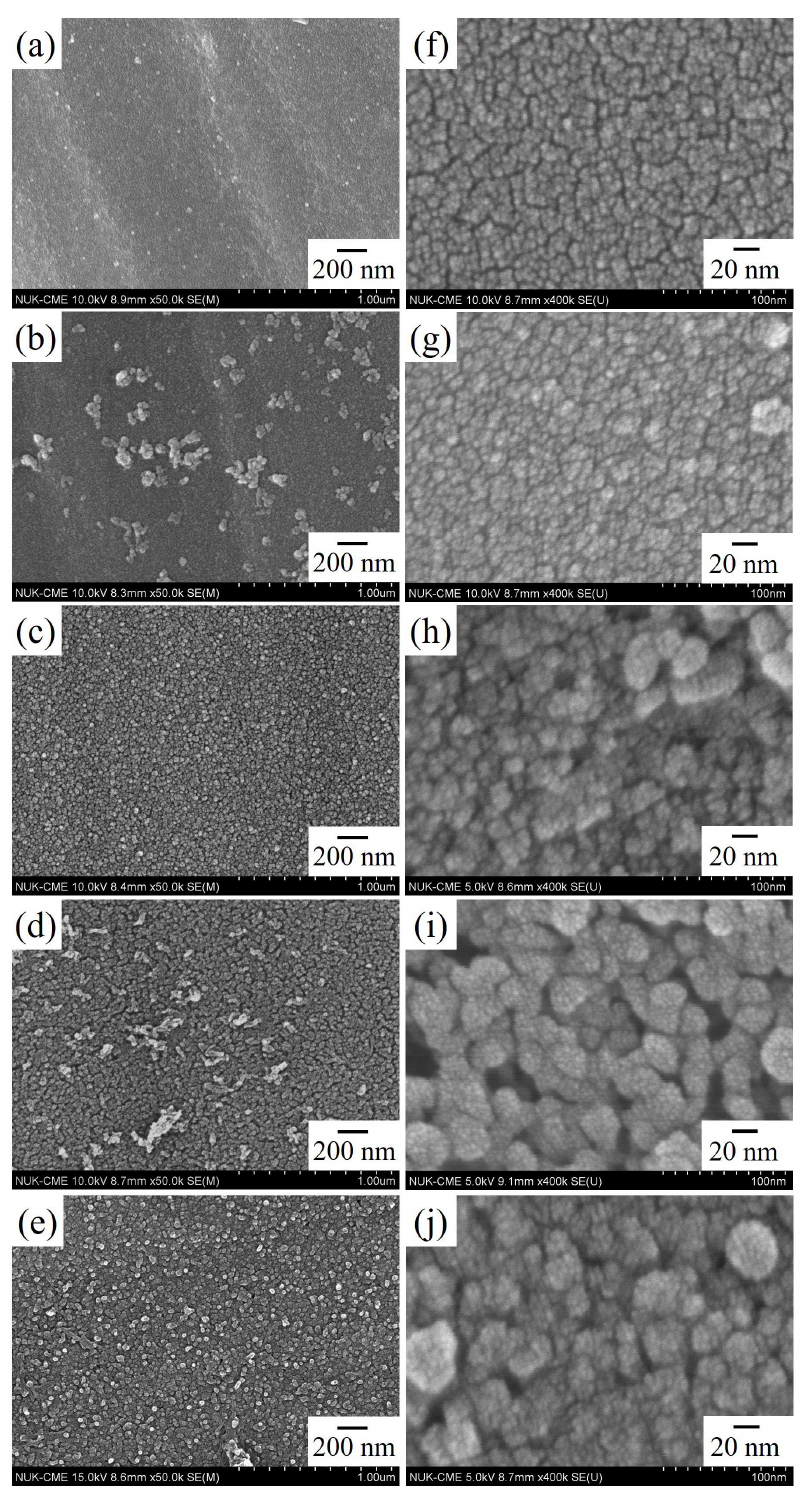
Figure 1. FE-SEM images of the coating surfaces of Ti–25Nb–8Sn alloy prepared by alkali treatment and hydrothermal reaction under various hydrothermal temperatures for 24 h. ( a , f ) 100 °C; ( b , g ) 125 °C; ( c , h ) 150 °C; ( d , i ) 175 °C; ( e , j ) 200 °C.